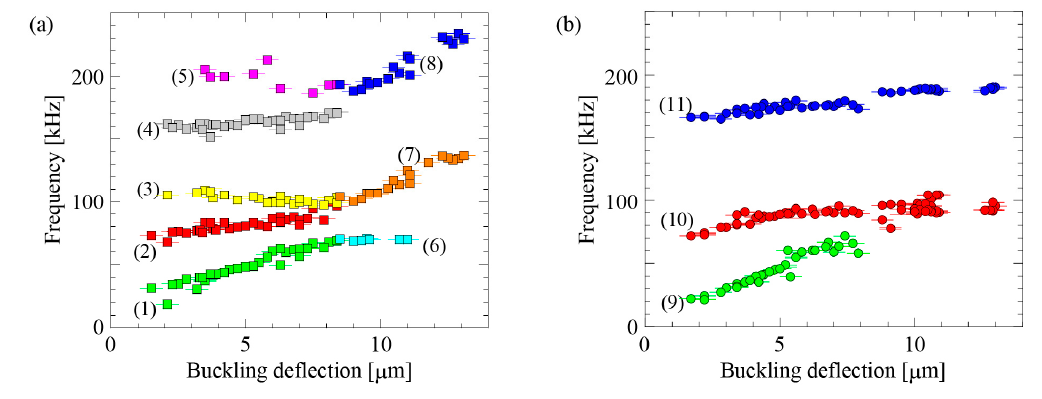
Figure 4. Natural frequencies of the centrosymmetric vibration modes versus buckling deflection: ( a ) square diaphragms, and ( b ) circular diaphragms. Error bars indicate maximum and minimum values and plot marker indicates average value in 10-time